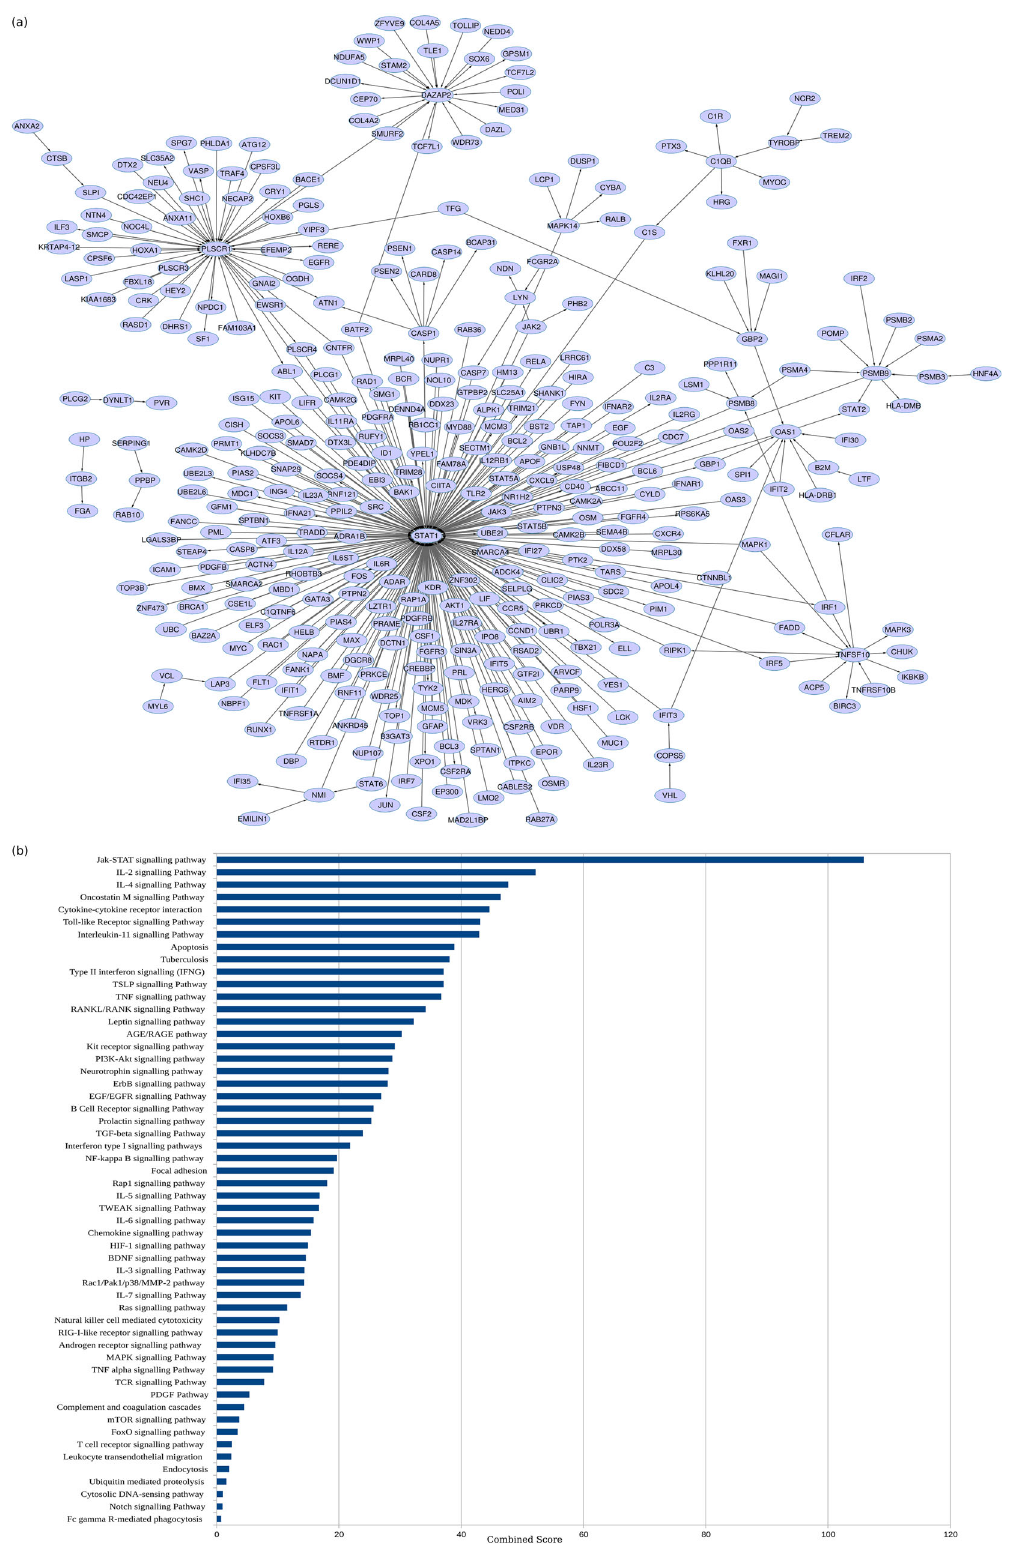
Fig. 3 a The emergent common core characteristic of the host response in tuberculosis. b Pathway enrichment ( p ≤ 0.05) highlights most signi fi cant biological pathways in the